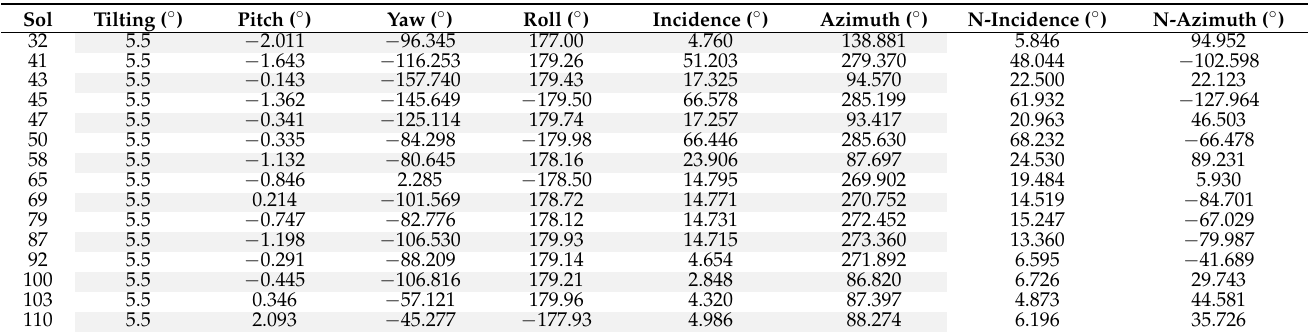
Table 2. 15 sols’ gray panel attitudes, with the new incidence and azimuth.